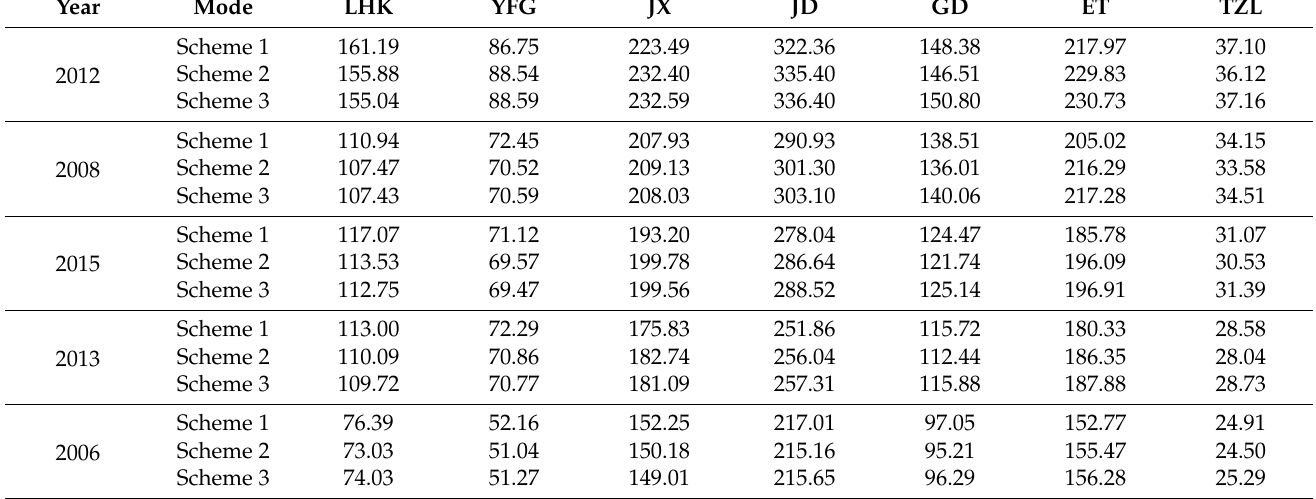
Table 4. Power generation (10 8 kWh) of each reservoir obtained by the three schemes in the five typical